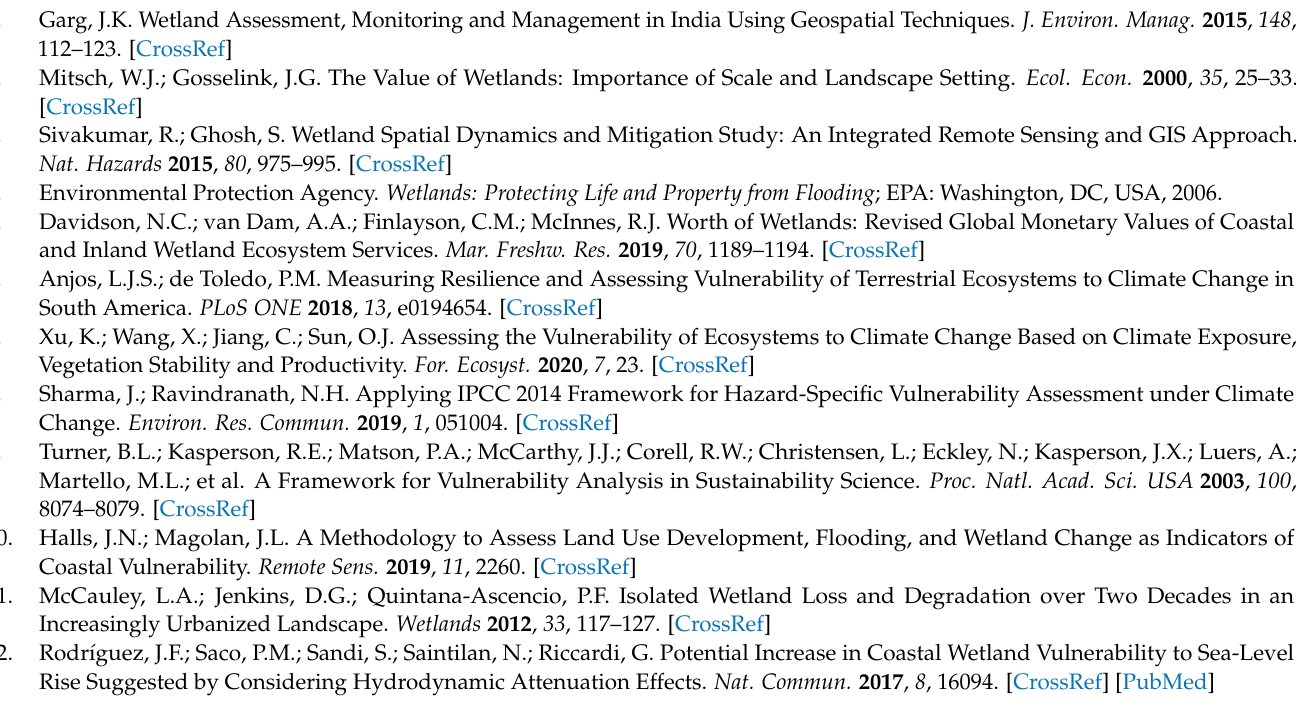
Table S1 Dates of Landsat 8 data utilized for the sensitivity time series analysis. Figure S5. Detailed wetland vulnerability assessment workflow showing intermediary computational steps for ArcGIS Pro implementation. Figure S6. SAVI time series wetland sensitivity results of the Masonboro Island- Mason Inlet and Smith Creek subwatersheds in New Hanover County, NC. Figure S7. NDMI time series wetland sensitivity results of the Masonboro Island-Mason Inlet and Smith Creek subwater- sheds in New Hanover County,